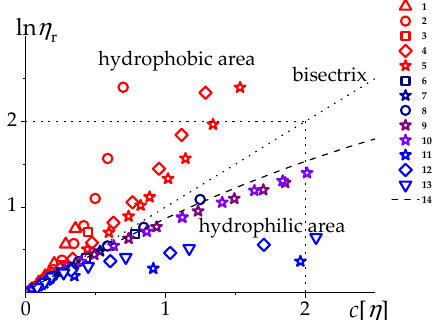
Figure 6. The dependence of the ln η r on the degree of dilution c [ η ] for MVAA- co -MVAC 12 H 25 with different molecular masses in aqueous 0.1 M NaCl (1–5), DMFA + 0.1 M LiCl (6–8), in H 2 O (11–13), MVAA- co -MVAC 6 H 13 (9) and MVAA- co -MVAC 8 H 17 (10) in aqueous 0.1 M NaCl solution and PMVA in H 2 O (14). The dashed line ln η r = c [ η ] separates two regions: the region of polymers with hydrophobic interactions and the region of polymers with hydrophilic